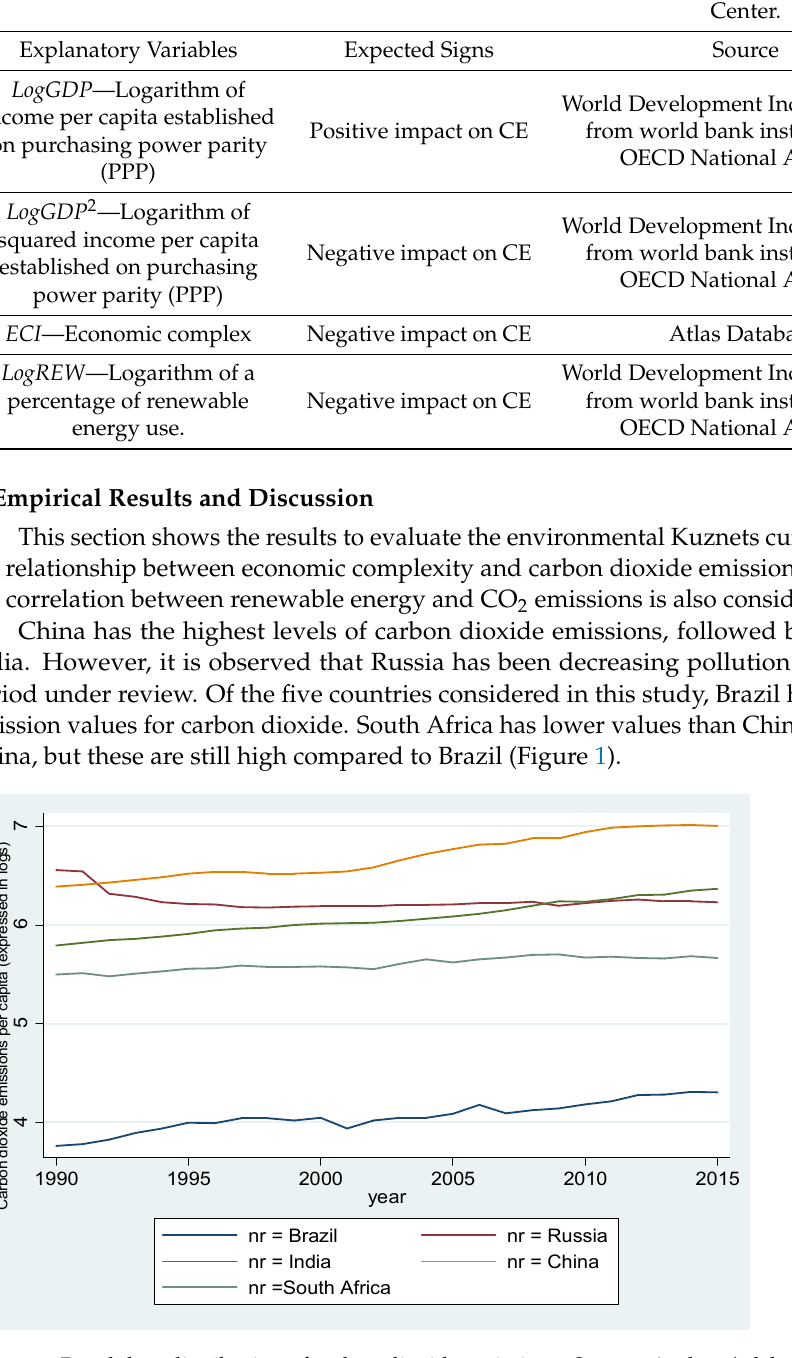
Figure 1. Panel data distribution of carbon dioxide emissions. Source: Authors’ elaboration based on World Development Indicators (2021).